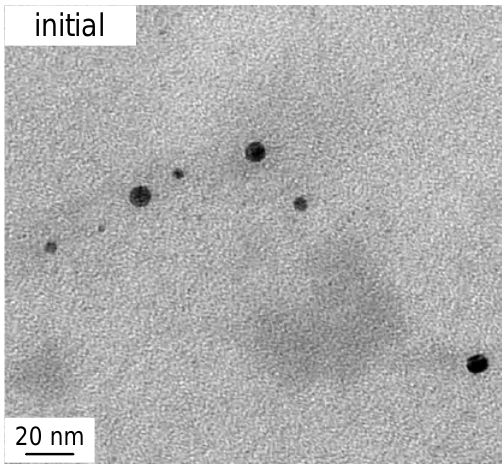
Figure 2. A detail of cryo-TEM image of initial sample showing particles of size 3–8 nm.